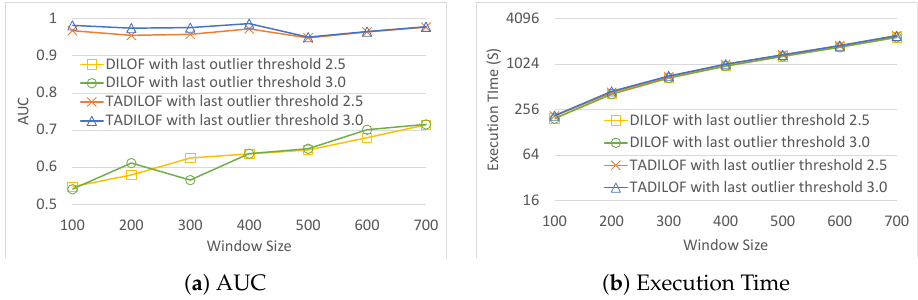
Figure 9. AUC and execution time on KDD 99 HTTP dataset using skipping